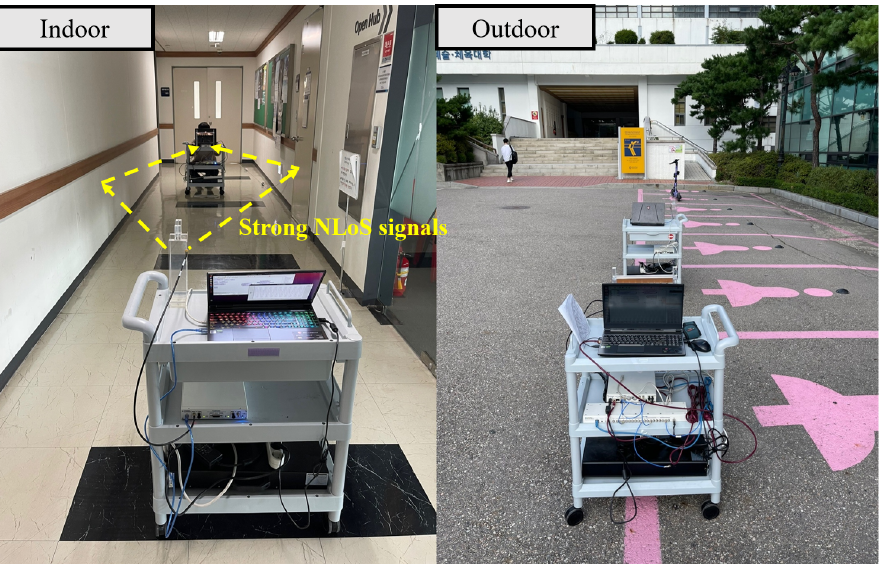
Figure 3. A picture of the indoor hallway and outdoor parking lot. The NLoS signals were expected to be strong in the indoor